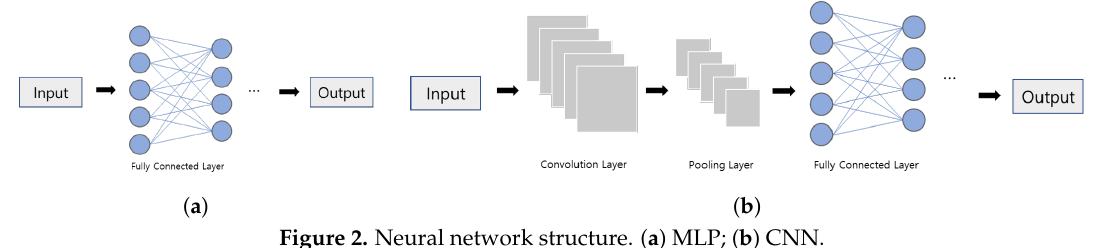
Figure 2. Neural network structure. ( a ) MLP; ( b ) CNN.